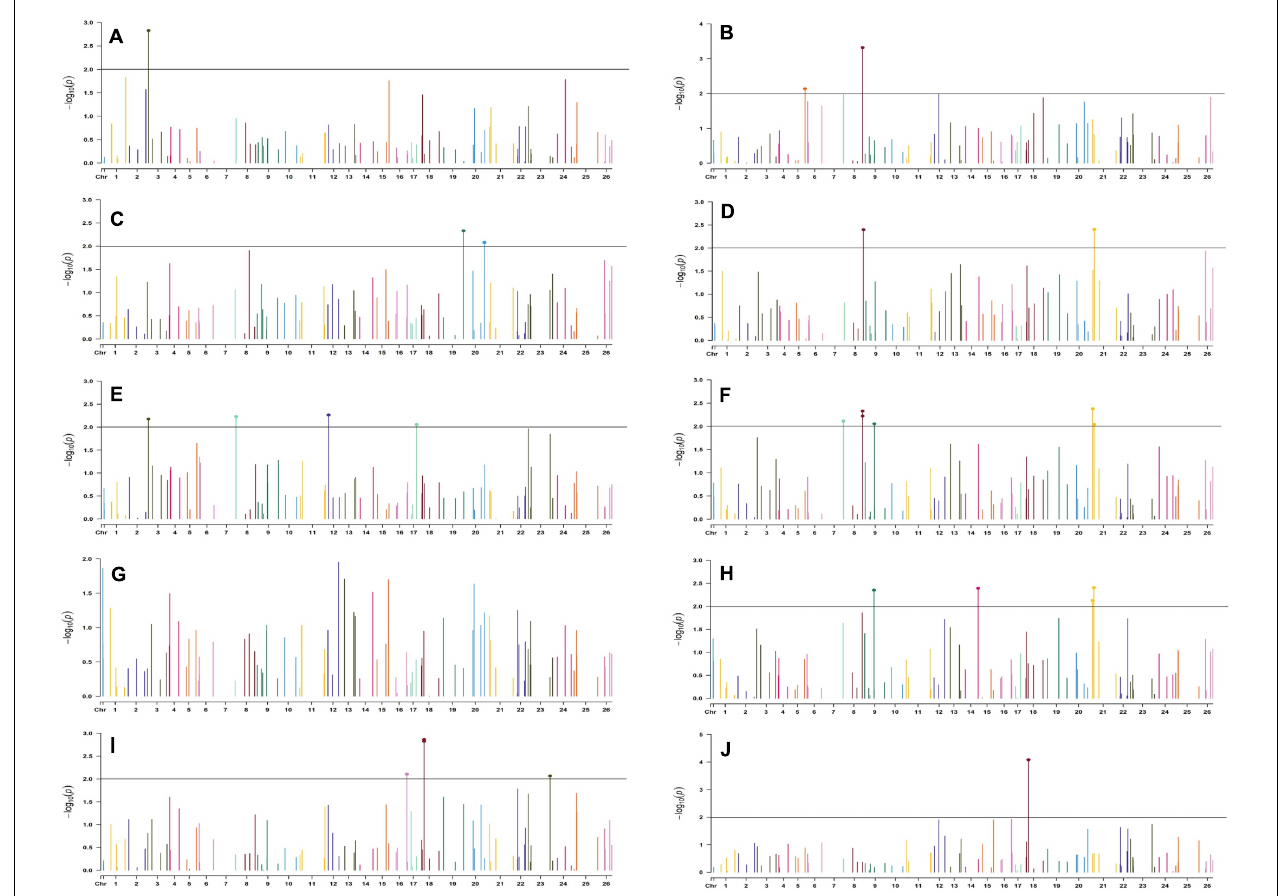
FIGURE 10 | Manhattan plots for the late sown environment of 2019 for various traits under study by the MLMM model. Significant marker above threshold {at –log10 ( p ) > 2} is highlighted with bold dot head on the marker’s line. (A) Days to first flower, (B) plant height, (C) number of monopods, (D) number of bolls per plant, (E) boll weight, (F) seed cotton yield per plant, (G) ginning out turn, (H) lint yield, (I) seed index, and (J) lint